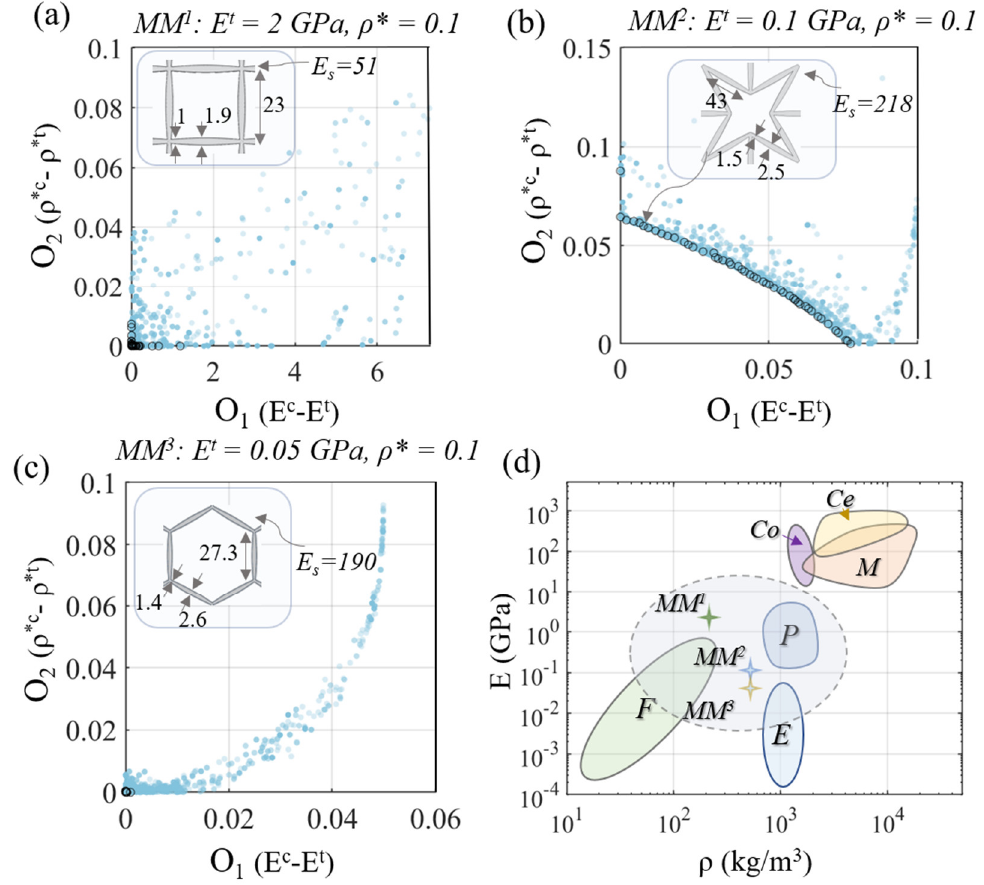
Figure 9. Optimal Pareto front for a multiscale square lattice with a target modulus of E t = 2 GPa and a relative density of 0.1 ( a ). The optimal pareto front solution for a multiscale square re-entrant and multiscale honeycomb cellular with a target modulus of E t = 0.1 GPa and E t = 0.05 GPa and a relative density of 0.1 are provided in ( b ) and ( c ), respectively. Inversely identified structural multiscale cellular patterns are depicted in each case. The metamaterial (MM) effective modulus is presented in an Ashby diagram comparative form in ( d ). For completeness, the modulus-density ranges for foams (F), elastomers (E), polymers (P), metals (M), composites (Co) and ceramics (Ce) are